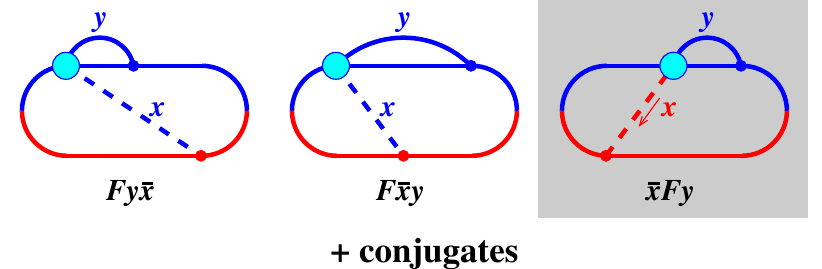
Figure 5 . Like figure 4 but for Class I virtual corrections to single splitting g → gg . Our terminology “Class I” [19] means that (i) y should be integrated over 0 < y < 1 − x for these diagrams and (ii) x → 1 − x generates another, distinct set of diagrams.